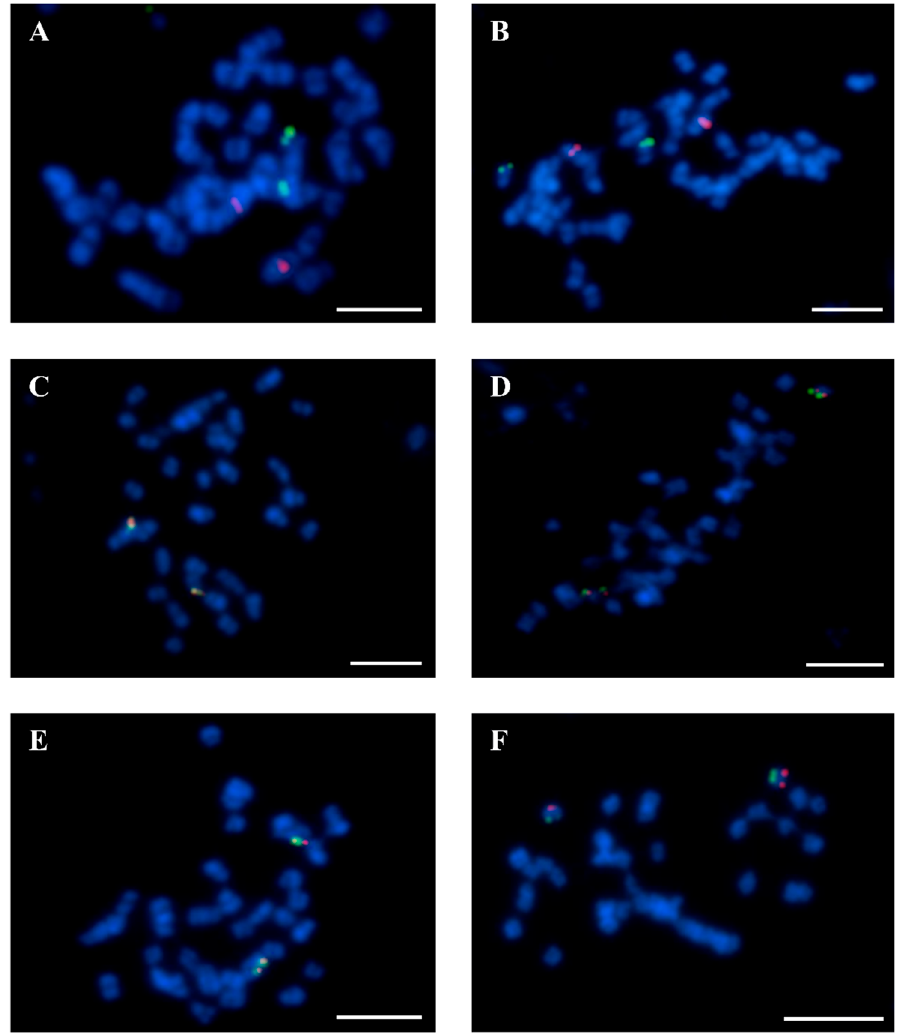
Figure 1. Fluorescence in situ hybridization verification of BAC localization in chromosomes of L. angustifolius . ( A ) BAC 43C18 (red signals)—Lang 01 and BAC 51F15 (green signals)—Lang 13. ( B ) BAC 2B03 (red)—Lang07 and 74I10 (green)—Lang19. ( C ) 67C07 (red)—Lang19 and 74I10 (green)—Lang19. ( D ) BAC 11G20 (red)—Lang13 and BAC 51F15 (green)—Lang13. ( E ) BAC 51F15 (red)—Lang13 and 8C03 (green)—Lang13. ( F ) 17B07 (red)—Lang20 and 1M23 (green)—Lang20. Chromosomes were stained with DAPI (blue). Scale bars = 5 µm.